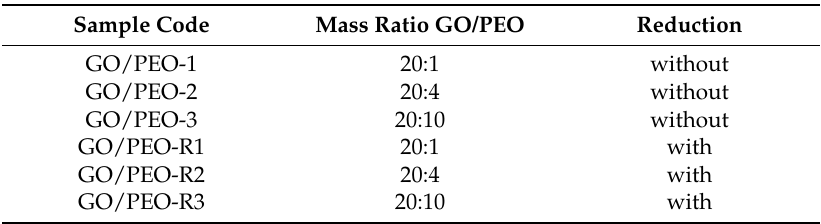
Figure 1. Schematic diagram of reduced graphene oxide film. Table 1. The composition of the composites. GO graphene oxide; PEO: high thermal conductive polyethylene